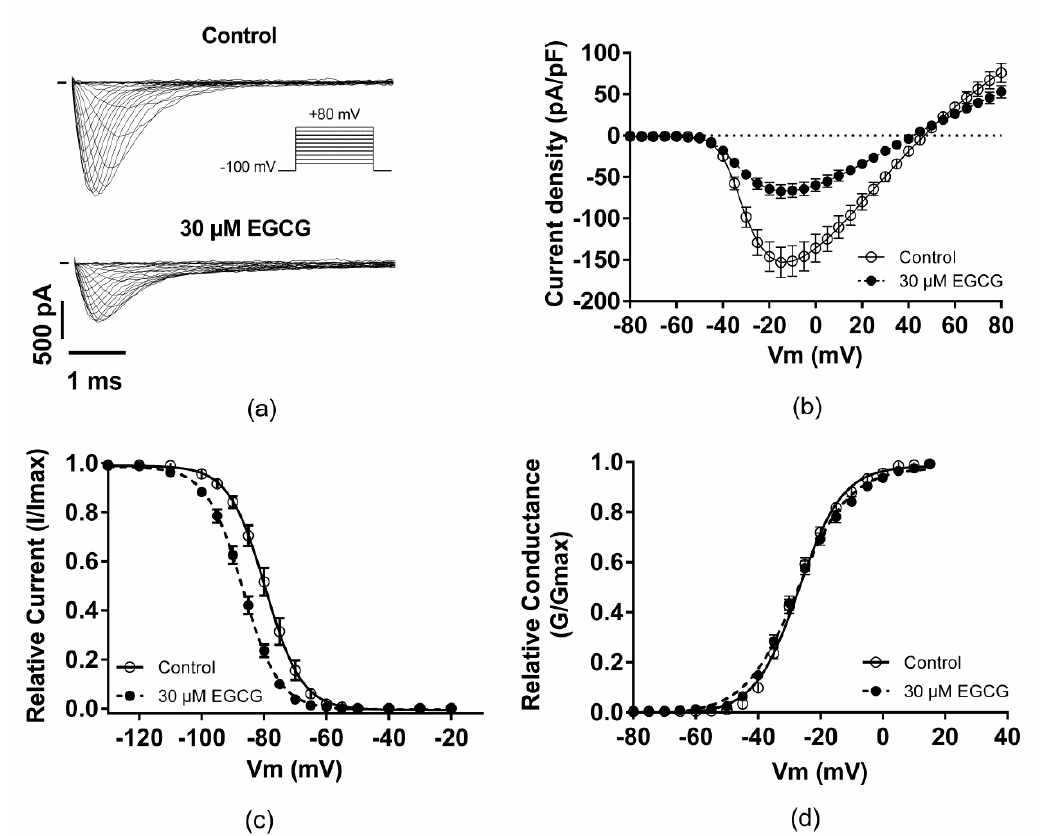
Figure 2. Effect of EGCG on the gating properties of Na v 1.5 channels. ( a ) Representative traces of I Na current in the presence or the absence of 30 µM of EGCG. ( b ) I/V relationship in the presence or the absence of EGCG. ( c and d ) Effect of EGCG on the voltage-dependence of inactivation and activation, respectively.